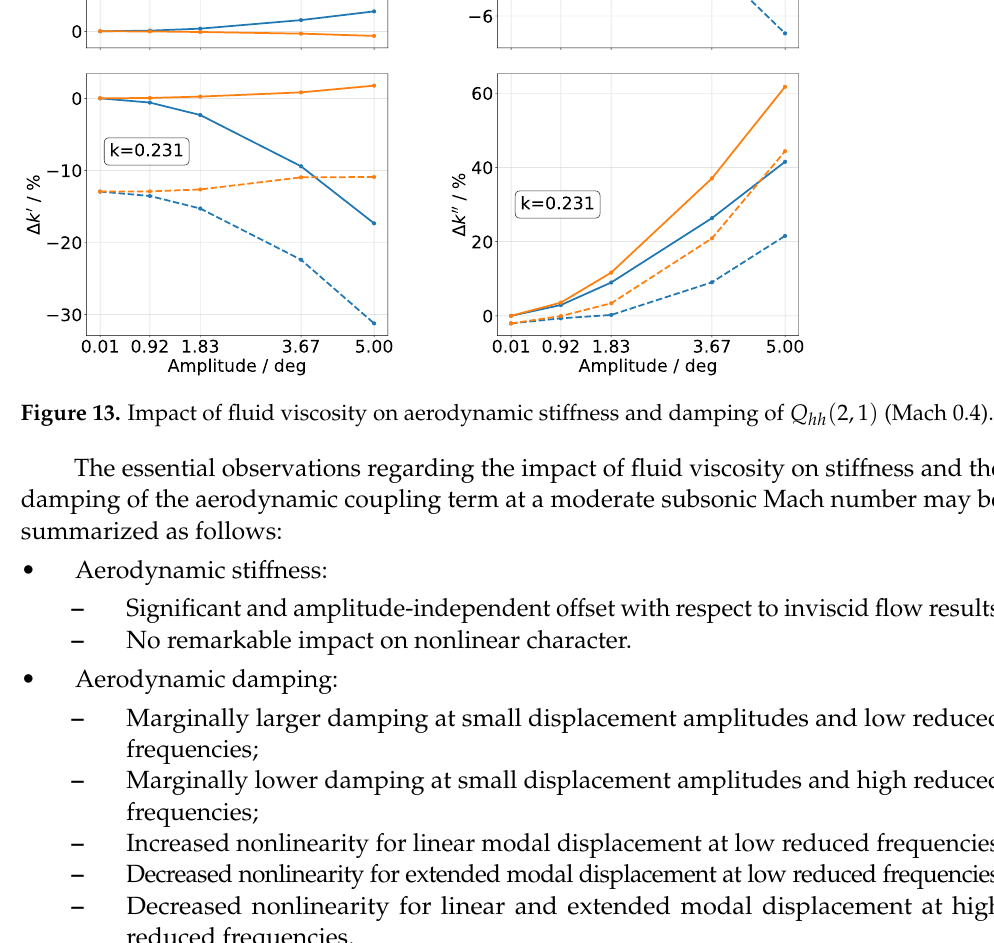
Figure 13. Impact of fluid viscosity on aerodynamic stiffness and damping of Q hh ( 2, 1 ) (Mach 0.4)